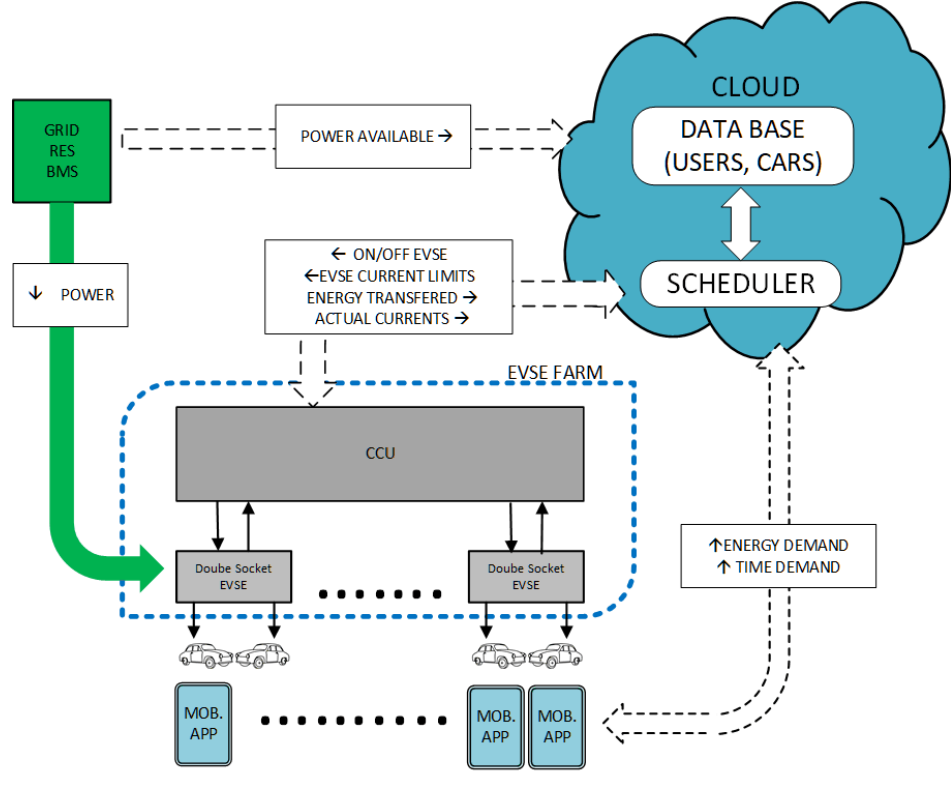
Figure 1. Block diagram of the analyzed farm of EV charging